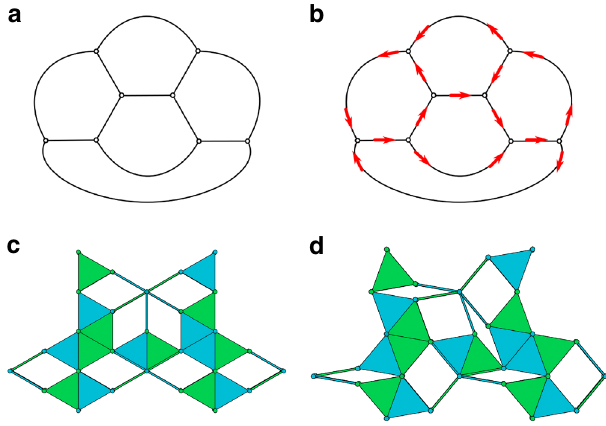
Fig. 6 Tiling method. Steps in obtaining a correct tiling pattern of pantographs: a dual graph of the net, where the vertices are the faces of the triangulated surface, b directed dual graph with correct orientation, c correct tiling pattern, d correct tiling pattern with θ ¼ 20